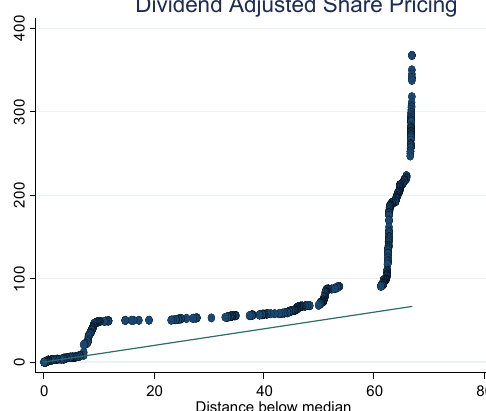
Figure 21. COVID-19 data Figure 22. Stocks returns